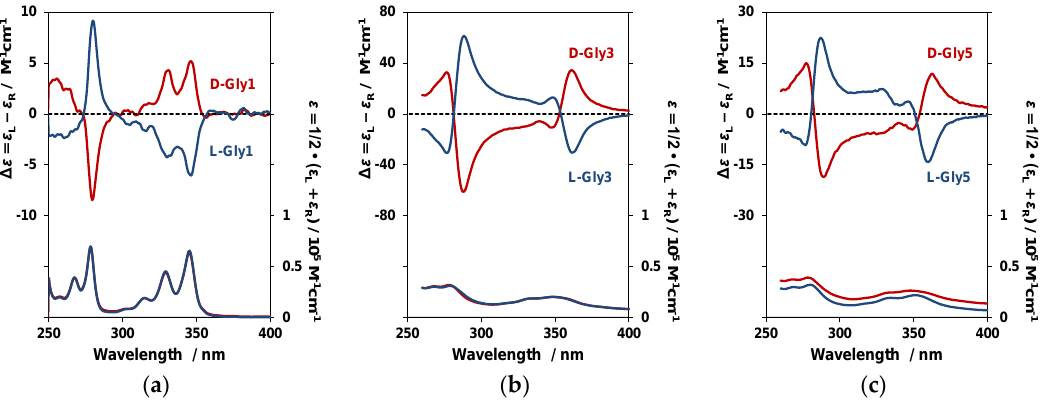
Figure 5. CD (upper panel) and UV–Vis (lower panel) spectra of ( a ) D -Gly1 / L -Gly1 [13]; ( b ) D -Gly3 / L -Gly3 ; ( c ) D -Gly5 / L -Gly5 in CHCl 3 (1.0 × 10 −4 M). D -isomer and L -isomer spectra are shown in red and blue, respectively. Path length = 1 mm.